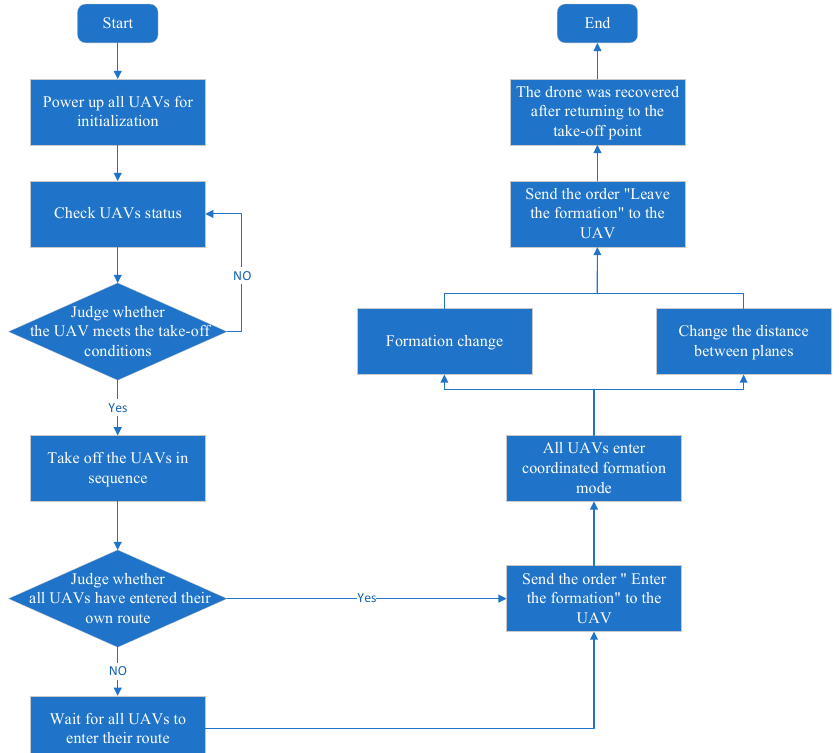
Figure 15. Formation flight test flowchart.